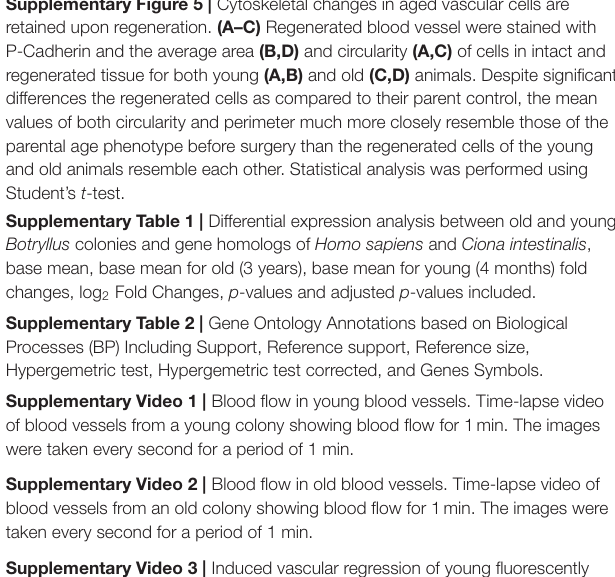
Supplementary Figure 5 | Cytoskeletal changes in aged vascular cells are retained upon regeneration. (A–C) Regenerated blood vessel were stained with P-Cadherin and the average area (B,D) and circularity (A,C) of cells in intact and regenerated tissue for both young (A,B) and old (C,D) animals. Despite significant differences the regenerated cells as compared to their parent control, the mean values of both circularity and perimeter much more closely resemble those of the parental age phenotype before surgery than the regenerated cells of the young and old animals resemble each other. Statistical analysis was performed using Supplementary Table 1 | Differential expression analysis between old and young Botryllus colonies and gene homologs of Homo sapiens and Ciona intestinalis , base mean, base mean for old (3 years), base mean for young (4 months) fold changes, log 2 Fold Changes, p -values and adjusted p -values included. Supplementary Table 2 | Gene Ontology Annotations based on Biological Processes (BP) Including Support, Reference support, Reference size, Hypergemetric test, Hypergemetric test corrected, and Genes